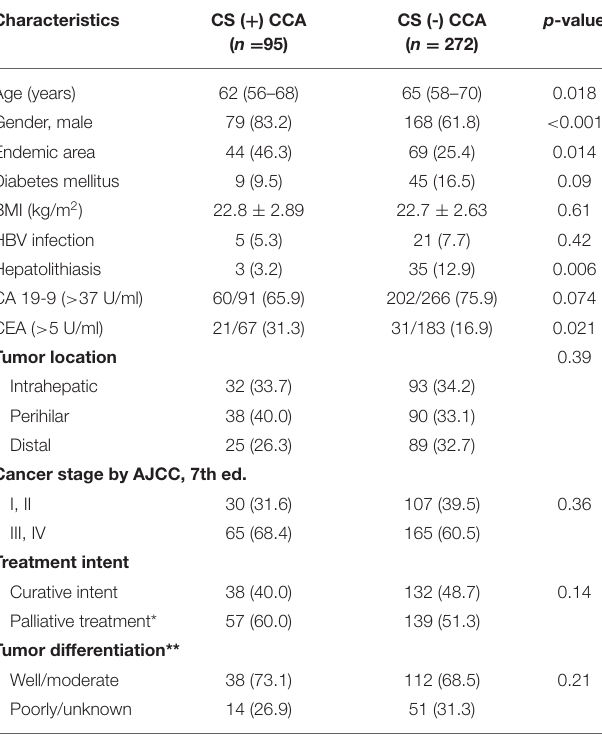
TABLE 1 | Baseline characteristics of 367 cholangiocarcinoma study patients. Characteristics